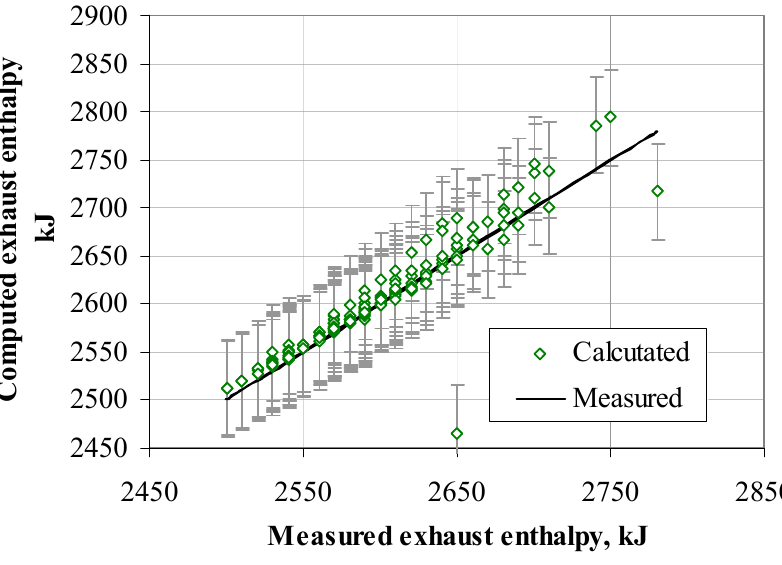
Figure 5. Comparison between calculated and real exhaust enthalpies of the working